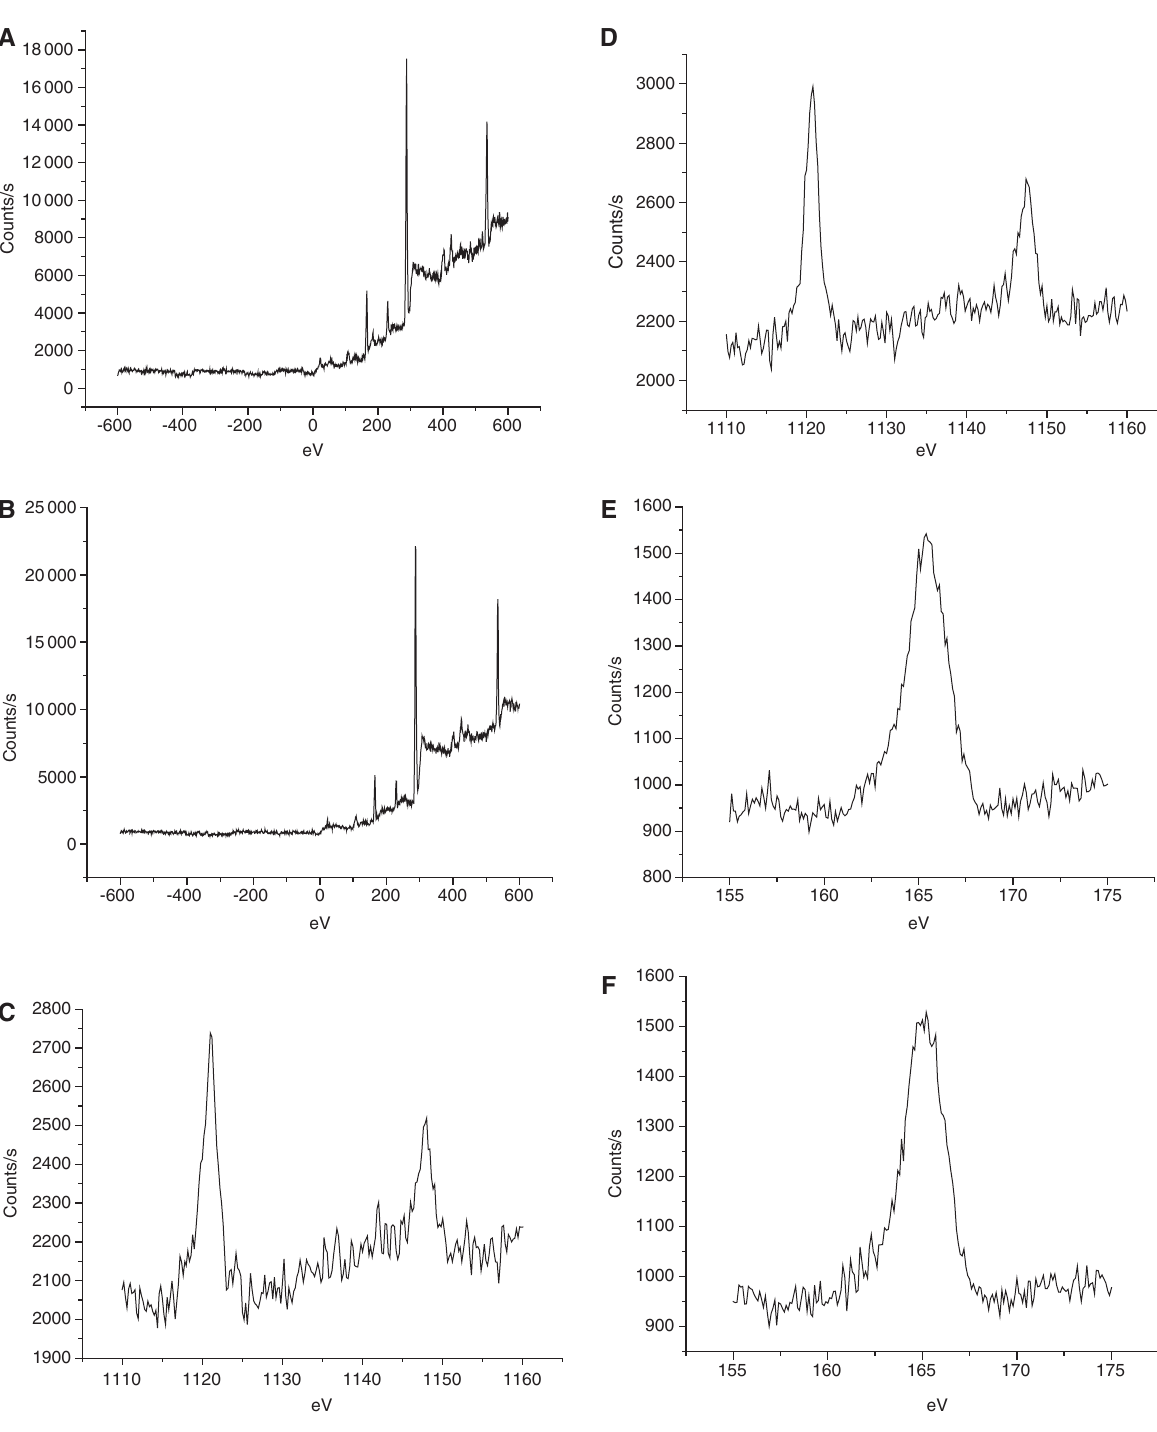
], (C and D) 2 electrons at 1120.0 eV and 2 3 p3/2